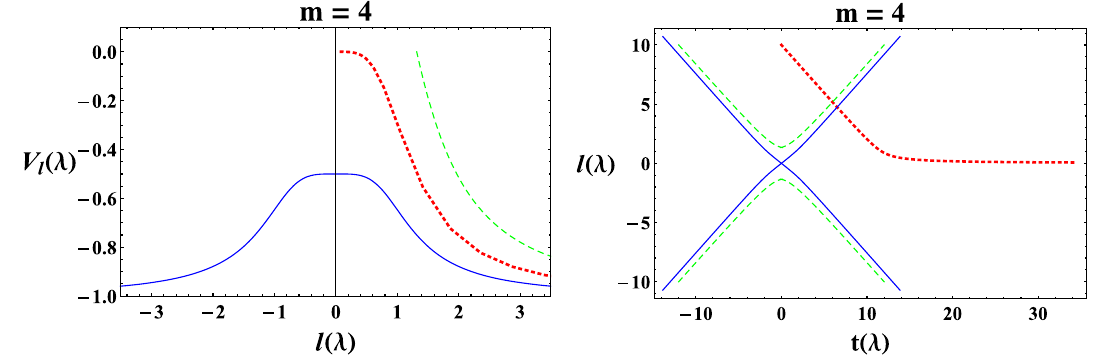
Fig. 6 Effective potential and geodesics for 4D-GEB wormhole ( m = 4): dotted-red, dashed-green, and continuous-blue curves representing – Trapped, Returning and Crossing geodesics respectively